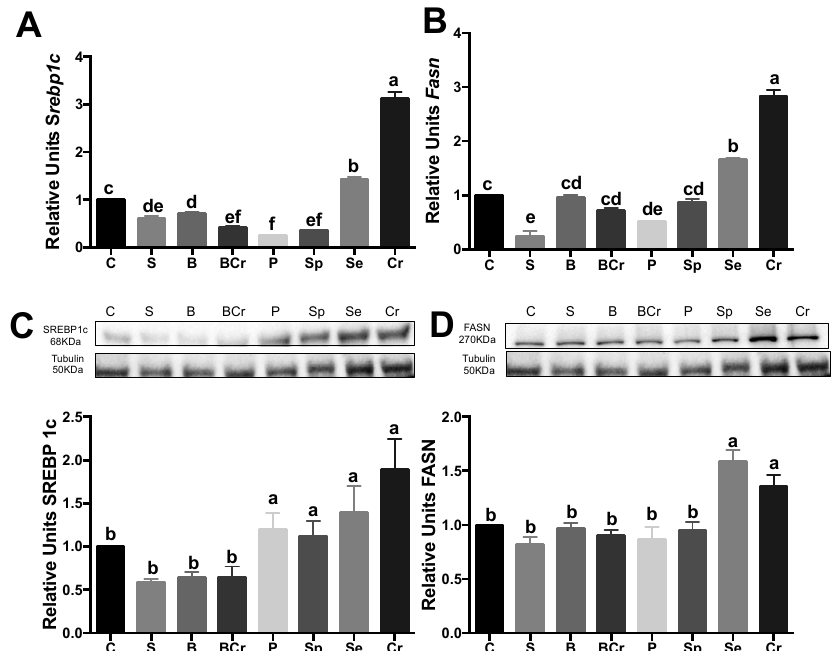
Figure 4. mRNA gene expression and Western blot analysis of SREBP1C and FASN in healthy rats: ( A ) Srebp1c and ( B ) Fasn mRNA abundance; ( C ) protein abundance of SREBP1c; and ( D ) FASN. Values are means ± SEM, n = 3. Different letter superscript in the bars indicates significant differences among groups, p < 0.05, a > b > c.